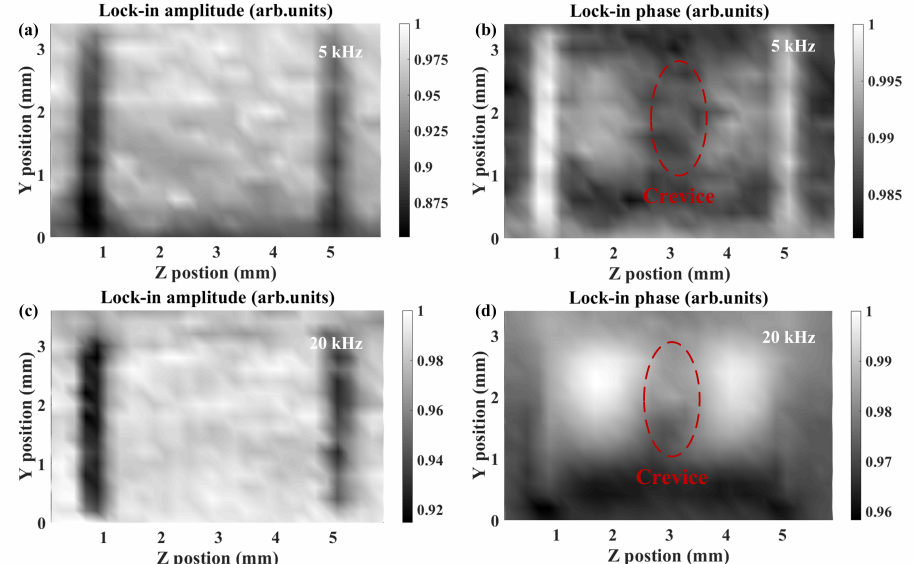
Figure 5. Imaging pictures of solid batteries with the crevice. ( a – d ) are amplitudes and phases of LIA for the battery with a crevice at frequencies of 5kHz and